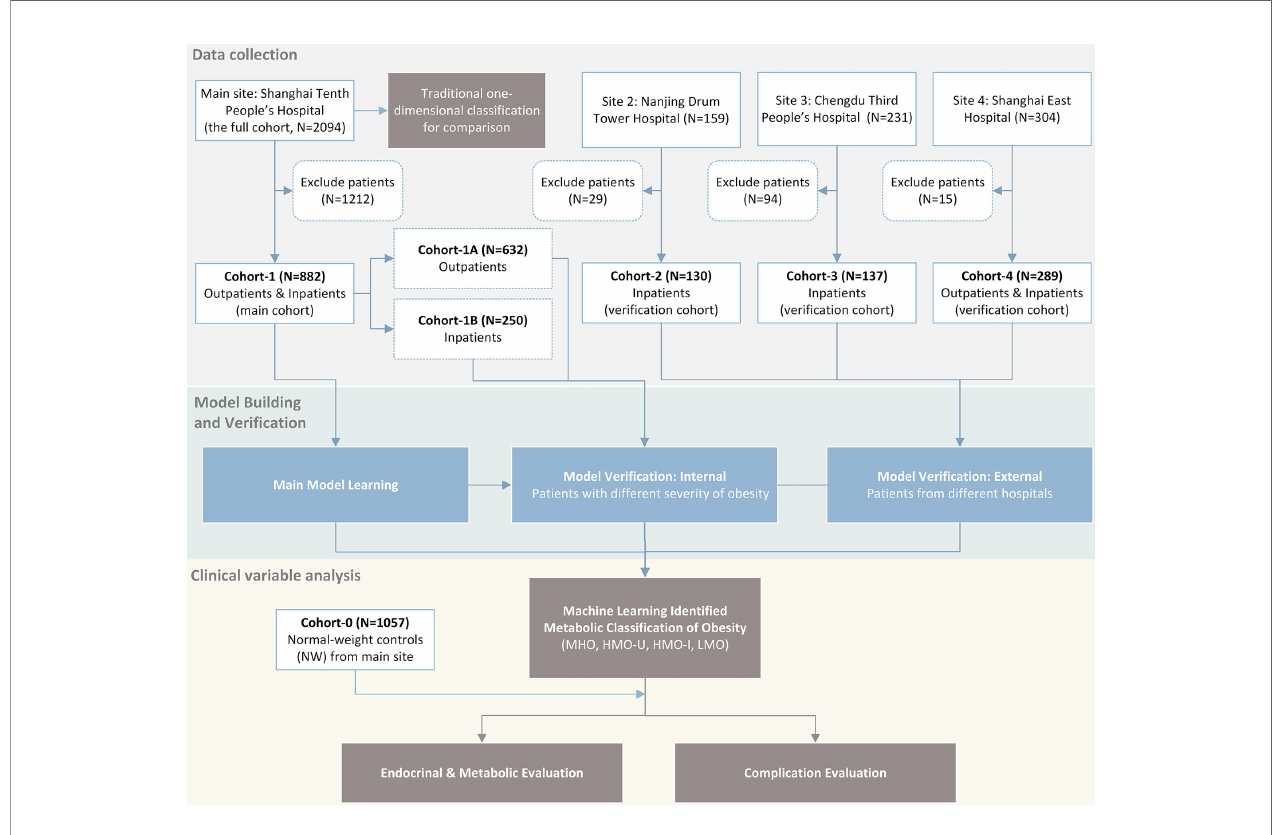
FIGURE 1 | Flow chart of study